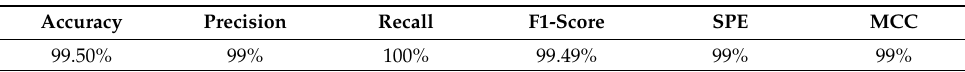
Table 2. The performance of the proposed